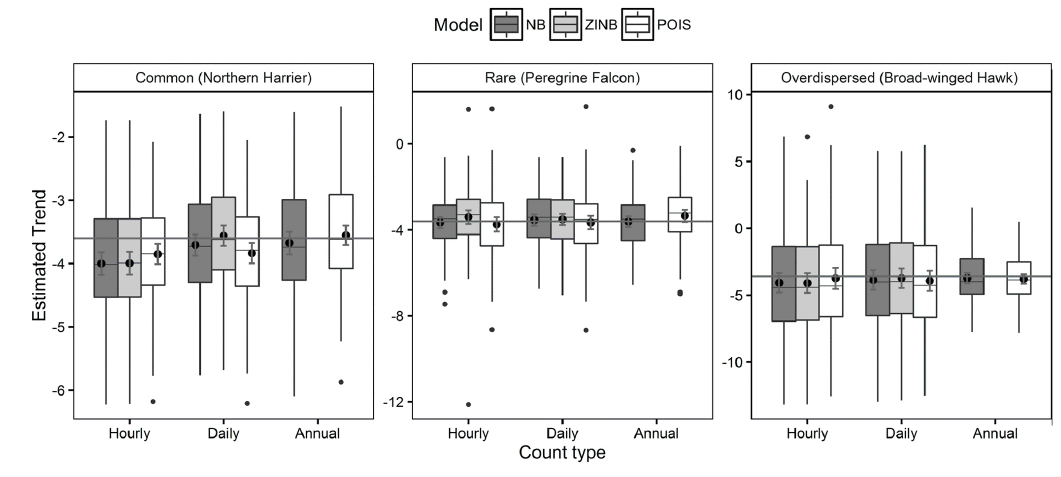
Fig. 1 . Box and whisker plots showing estimated trend %year -1 across 100 datasets simulated to represent a commonly detected species (e.g., Northern Harrier, Circus cyaneus ), a rarely detected species with zero-inflated counts (e.g., Peregrine Falcon, Falco peregrinus ) and a super-flocking species with highly over-dispersed (OD) counts (e.g., Broad-winged Hawk, Buteo platypterus ). Results are shown for trends estimated using hourly, daily, and annual migration counts, and assuming a negative binomial (NB), zero-inflated NB (ZINB; hourly and daily data only), or Poisson (POIS) distribution of counts. Boxplots show 25th, 50th, 75th quartiles of the estimates, with black whiskers extending 1.5*interquartile range in each direction. Mean (± 95% CI) across simulated datasets are also shown by black dots with associated grey error bars. The solid horizontal line depicts the true, simulated trend of